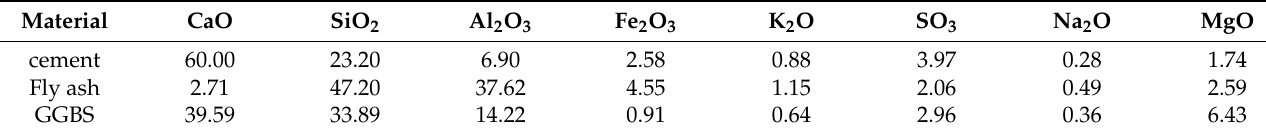
Table 2. Chemical compositions of the binder (%).